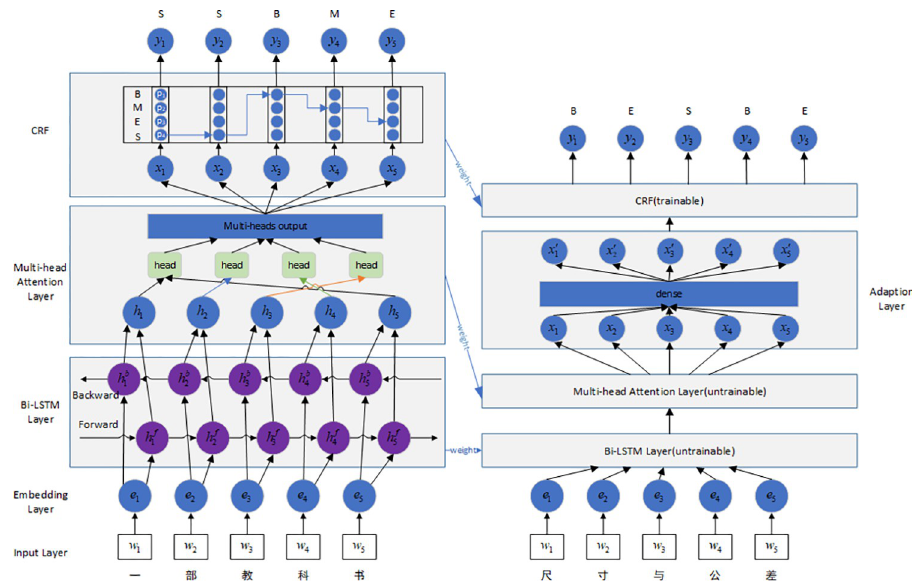
Fig 2. mTL-Bi-LSTM-MA-CRF model. Weights of the embedding, the Bi-LSTM, the multi-attention, and the CRF are pre-trained and shared with transfer learning. A weight of the adaptation layer is individually trained and a weight of the CRF is